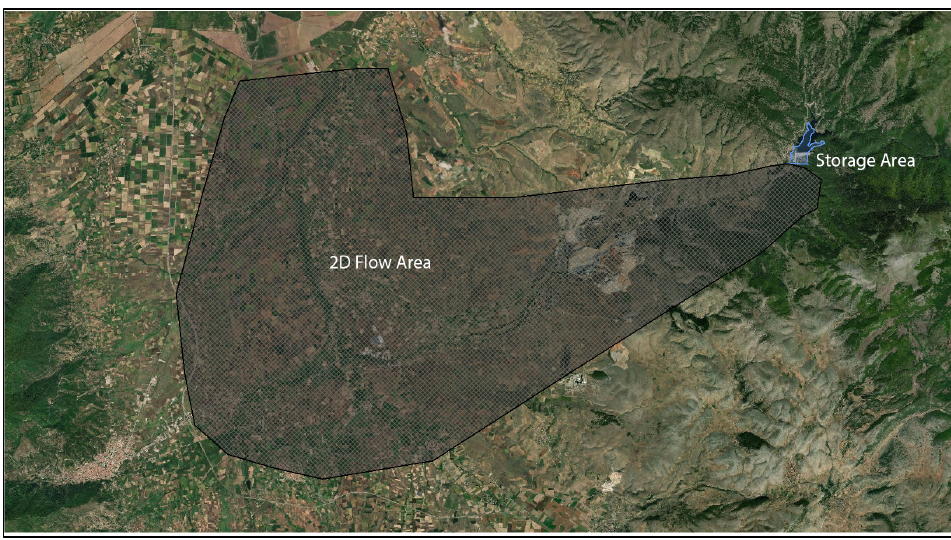
Figure 8. Two-dimensional flow area downstream of Papadia dam.